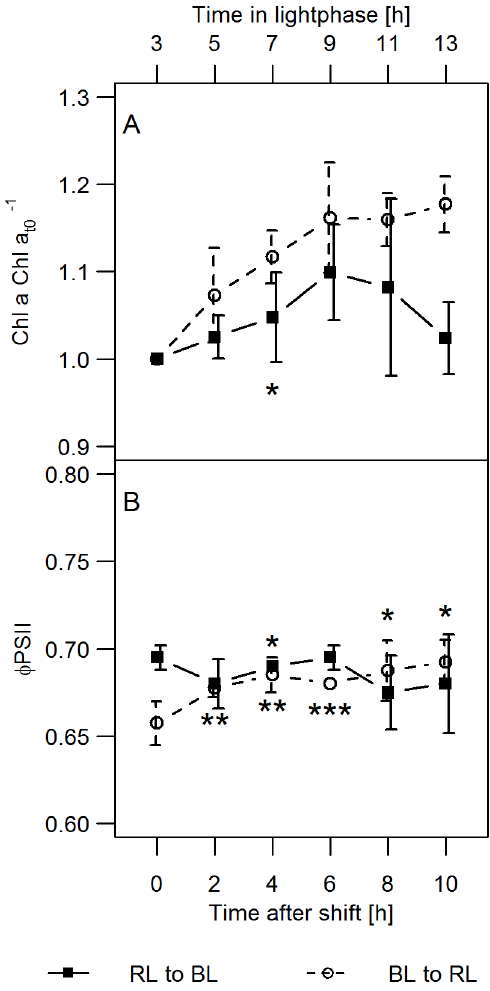
Figure 3. Short-term acclimation to light quality shifts. The changes in (A) the Chl a concentration and (B) W PSII of P. tricornutum cultures were recorded for 10 h after the light quality shift at t 0 from BL to RL and RL to BL. Additionally, the time in the light phase is given above the plot. The asterisks depict the p-values of the respective data point compared to the steady state the cultures were shifted from at the same time point (Chl a ) or the daily mean value when this was constant ( W PSII ). n=4–8 for the Chl a concentrations and n=3–4 for F V 9 F M 9 2 1 . The exact values are specified in Table S3.